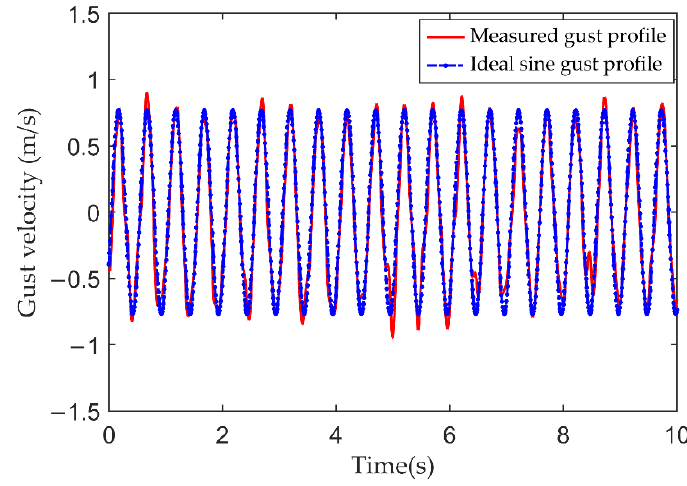
Figure 5. Comparison between measured gust profile and ideal sine gust profile.